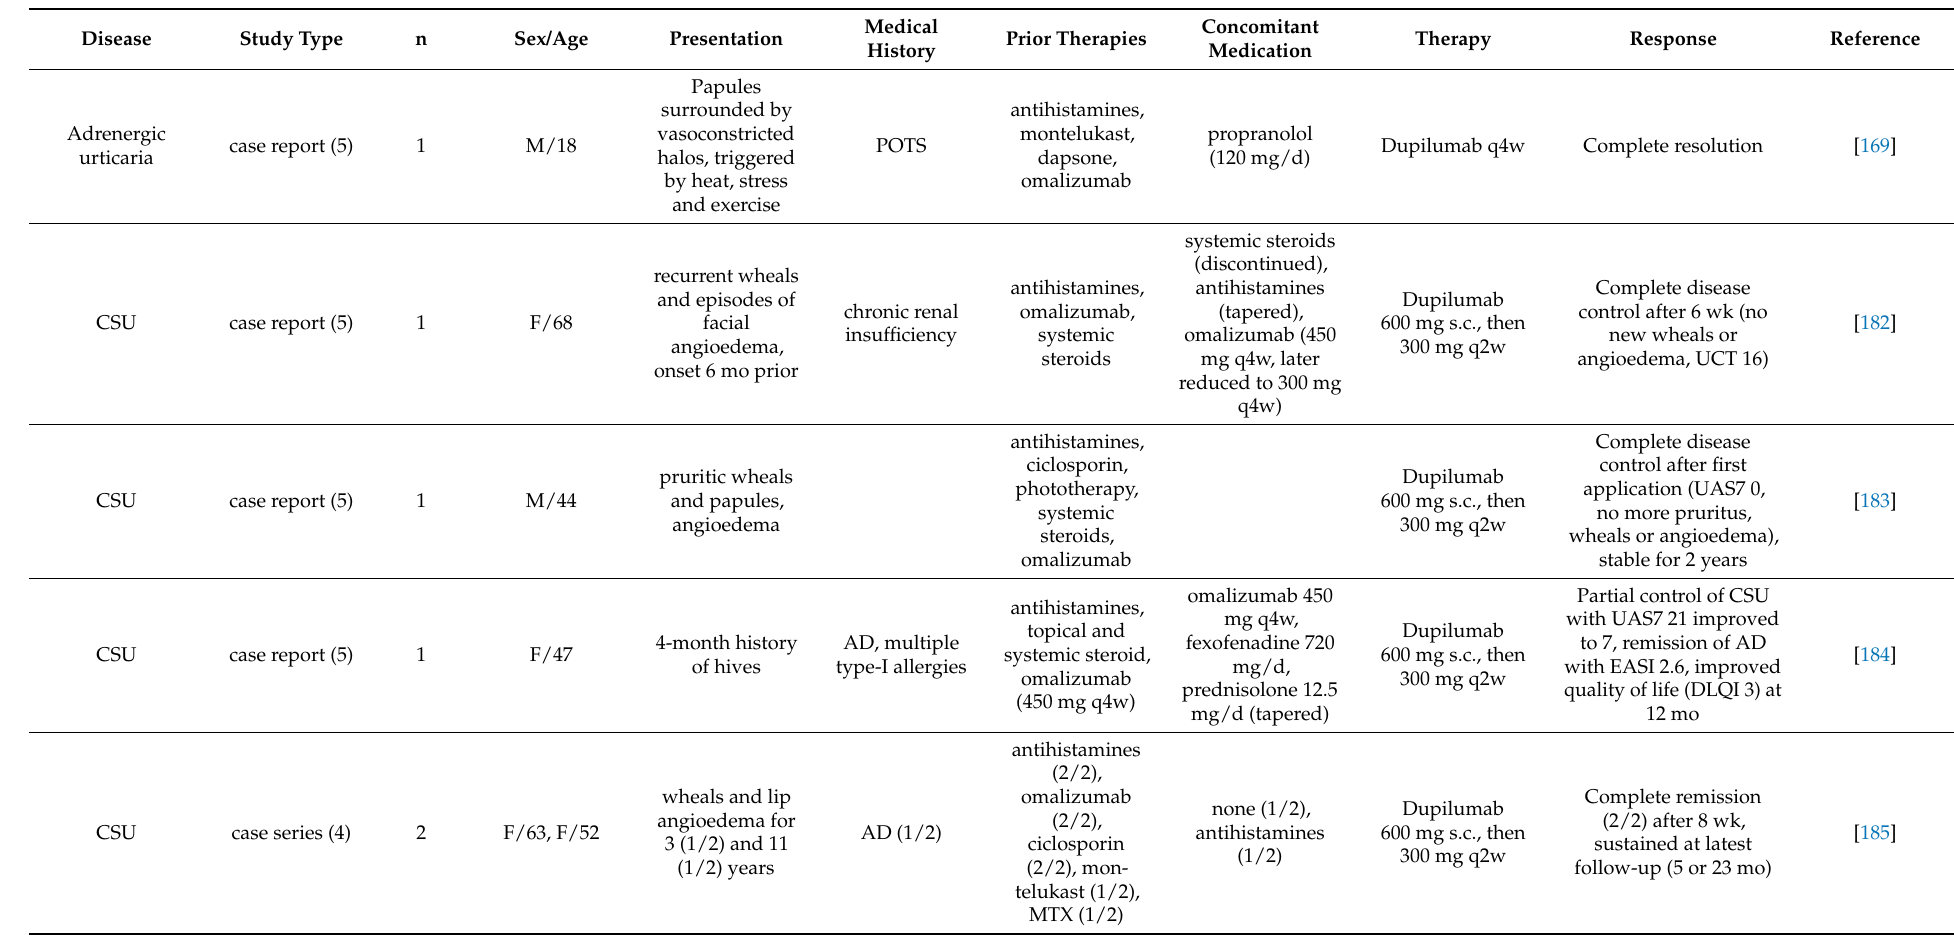
Table 5. Chronic